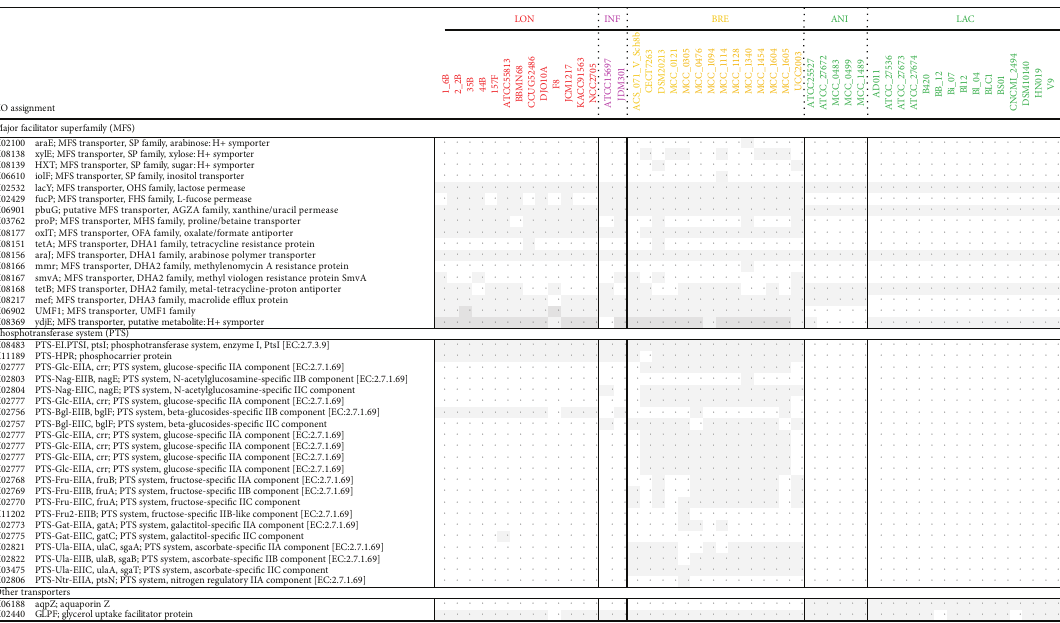
Figure 4: Distribution of genes encoding membrane transporters for carbohydrate. The abbreviations used for species/subspecies are as follows: INF, B. longum subsp. infantis ; LON, B. longum subsp. longum ; BRE, B. breve ; ANI, B. animalis subsp. animalis ; LAC, B. animalis subsp.